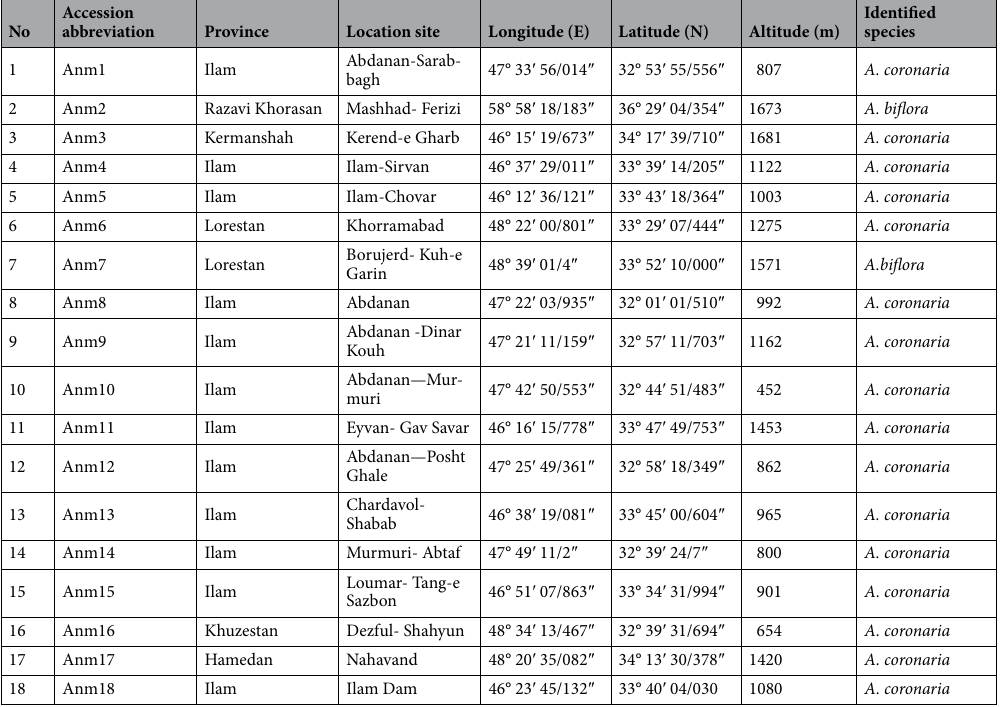
Table 9. Collection information for the 18 Anemone accessions